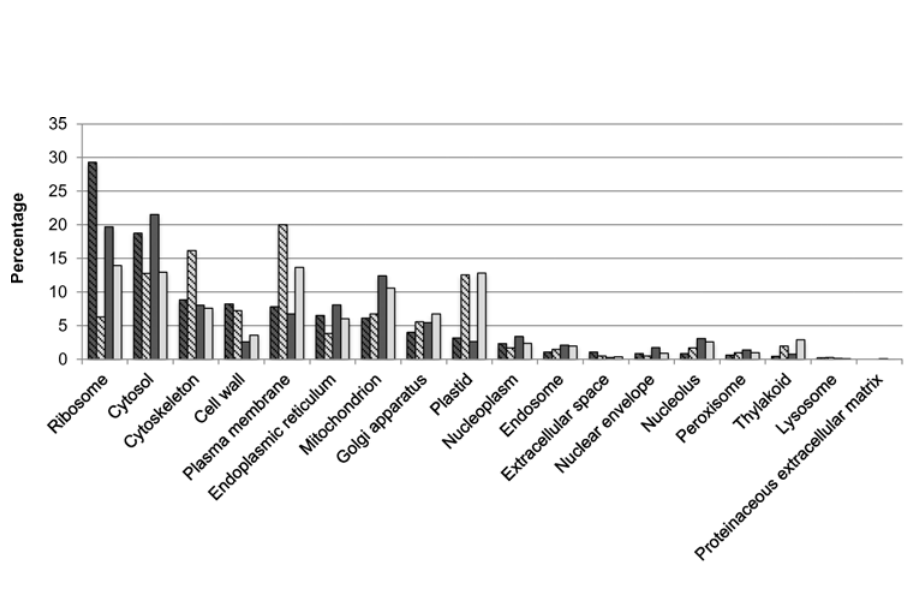
Fig 8. Percentage of upregulated and downregulated transcripts in the nickel — resistant and susceptible Betula papyrifera genotypes compared to control (nickel untreated samples). Transcripts were assigned gene ontology and grouped by molecular function using BLAST2GO.